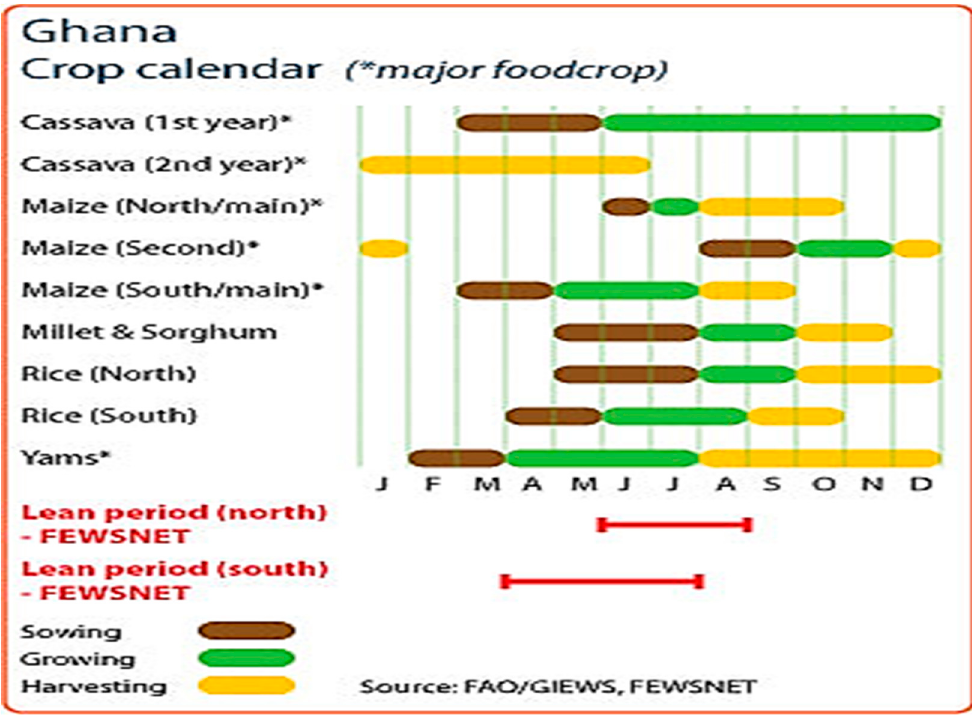
Figure 3. Major food crops calendar in Ghana.